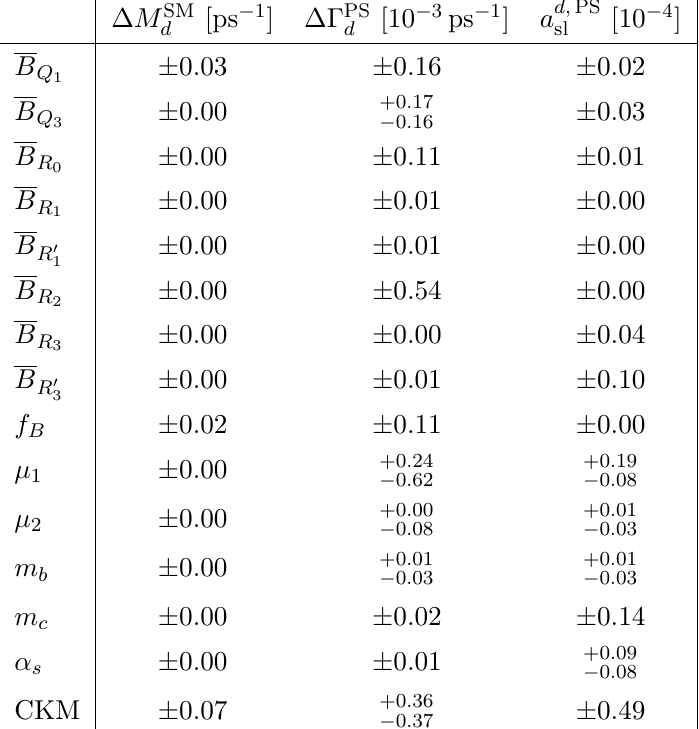
Table 7 . Individual errors for the B d mixing